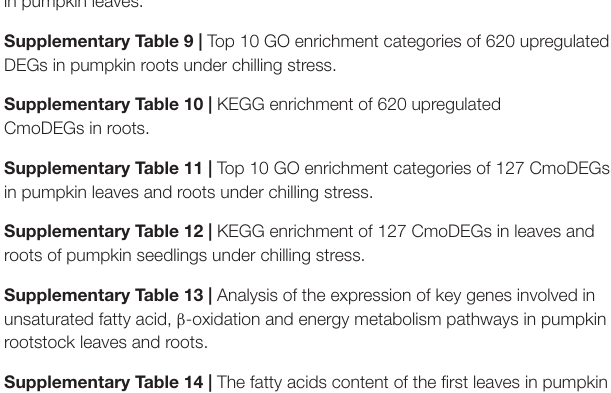
Supplementary Figure 2 | Physiological evaluation and principal component analysis (PCA) of seven pumpkin rootstock varieties under chilling treatment. (A)